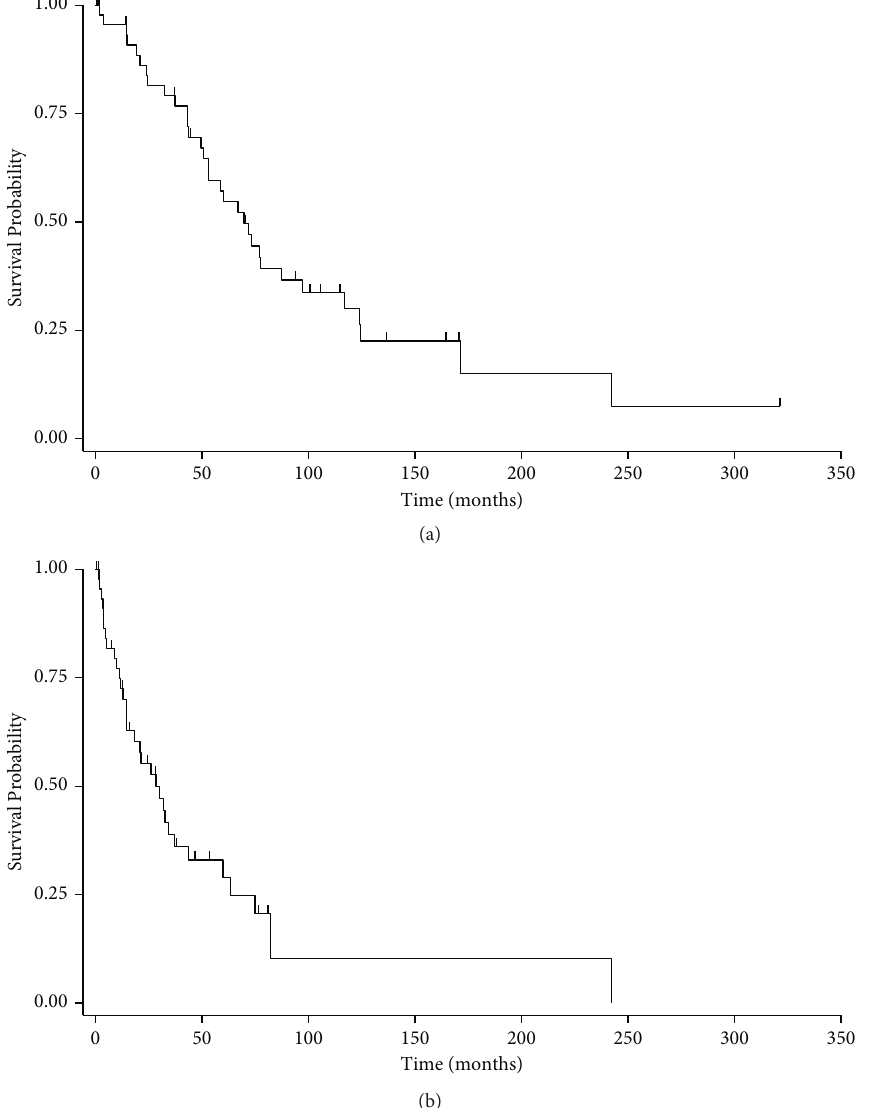
Figure 4: Kaplan–Meier survival curves by overall survival of all patients with metastatic leiomyosarcoma to bone from time of initial diagnosis (a) and survival after diagnosis of bone metastases (b). Vertical hash marks represent censored